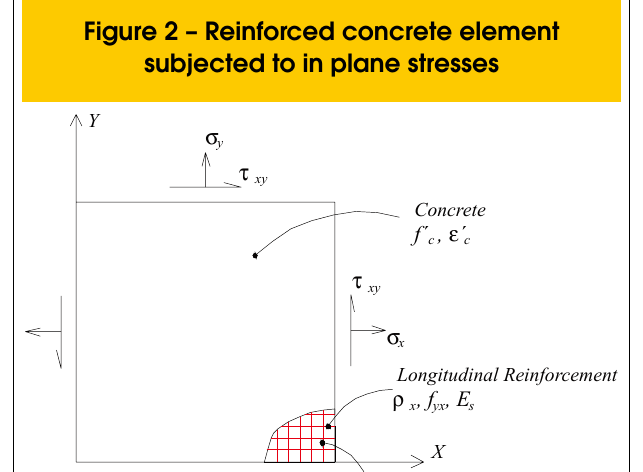
Figure 2 – Reinforced concrete element subjected to in plane